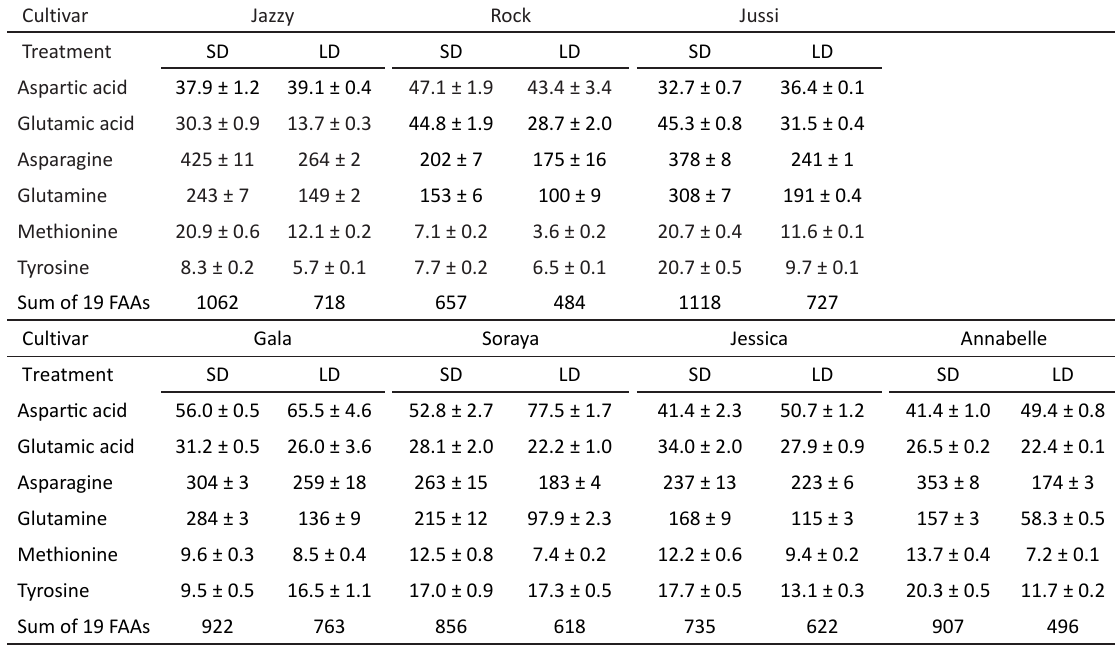
Table 3. Free amino acid concentrations (mean ± standard deviation of three technical replicates) of potato tubers as mg 100 g -1 fresh weight as a result of short day (SD) and long day (LD) treatments. Cultivar